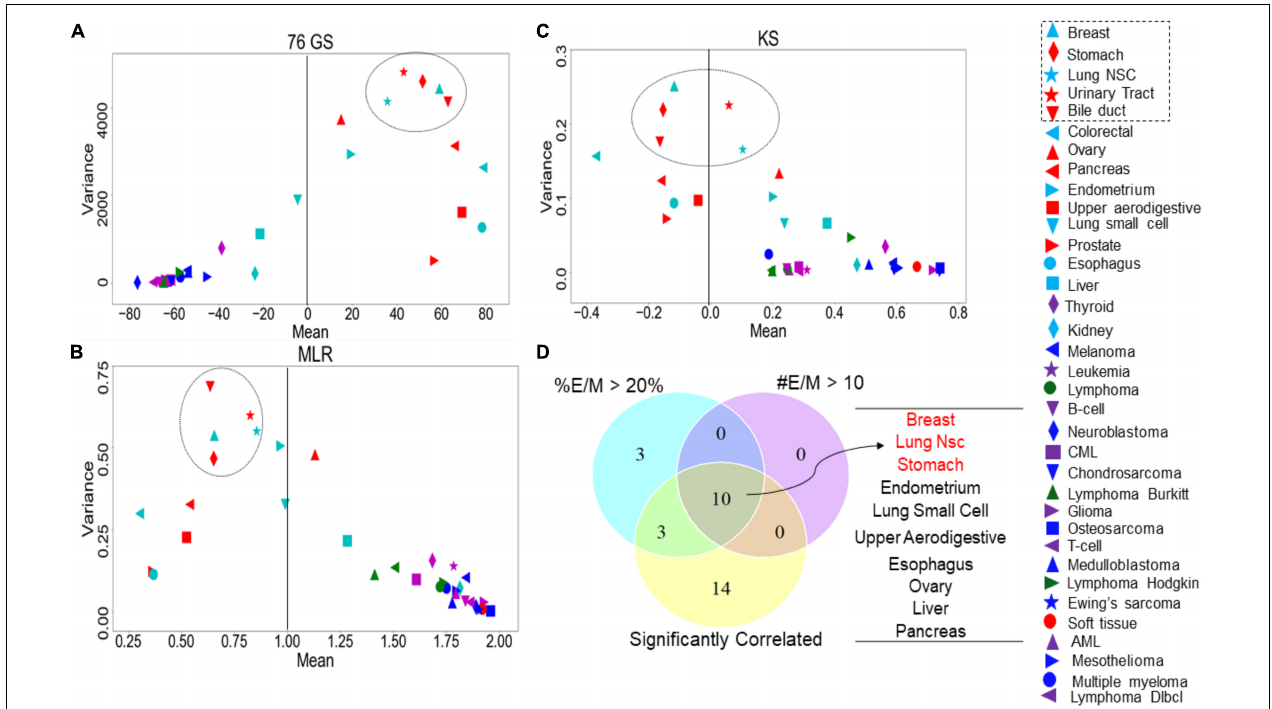
FIGURE 6 | Variance and mean of EMT scores in CCLE samples grouped by tumor subtype, highlighting the most variable tumor types (circled). (A) 76GS EMT scores, (B) MLR EMT scores, and (C) KS EMT scores. (D) Venn diagram showing the overlap between each tumor type based on the abundance of hybrid samples as defined by the MLR method, where #EM > 10 denote the cases where the absolute number of hybrid E/M samples in a tumor subtype is > 10; %EM > 20 denote the cases where the percentage of cell lines identified as hybrid E/M in a given tumor subtype is > 20%.